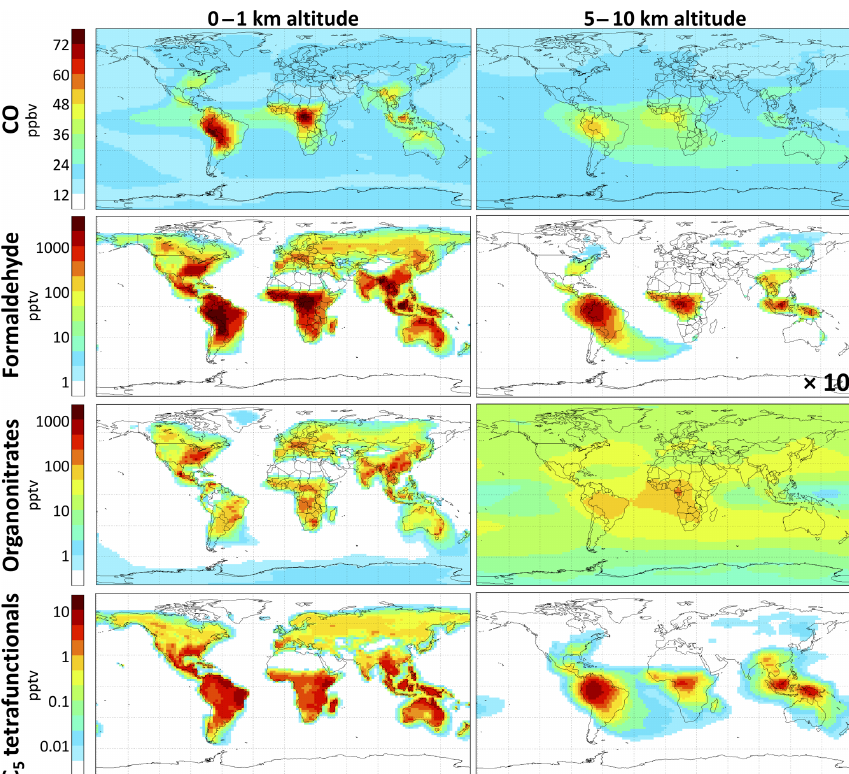
Figure 9. Contributions of isoprene to concentrations of CO, formaldehyde, organonitrates (including peroxyacyl nitrates), and C 5 tetrafunc- tional compounds using RCIM. Values are annual averages, calculated as the differences between GEOS-Chem simulations with and without isoprene emissions. Color scale is linear for CO and logarithmic for other